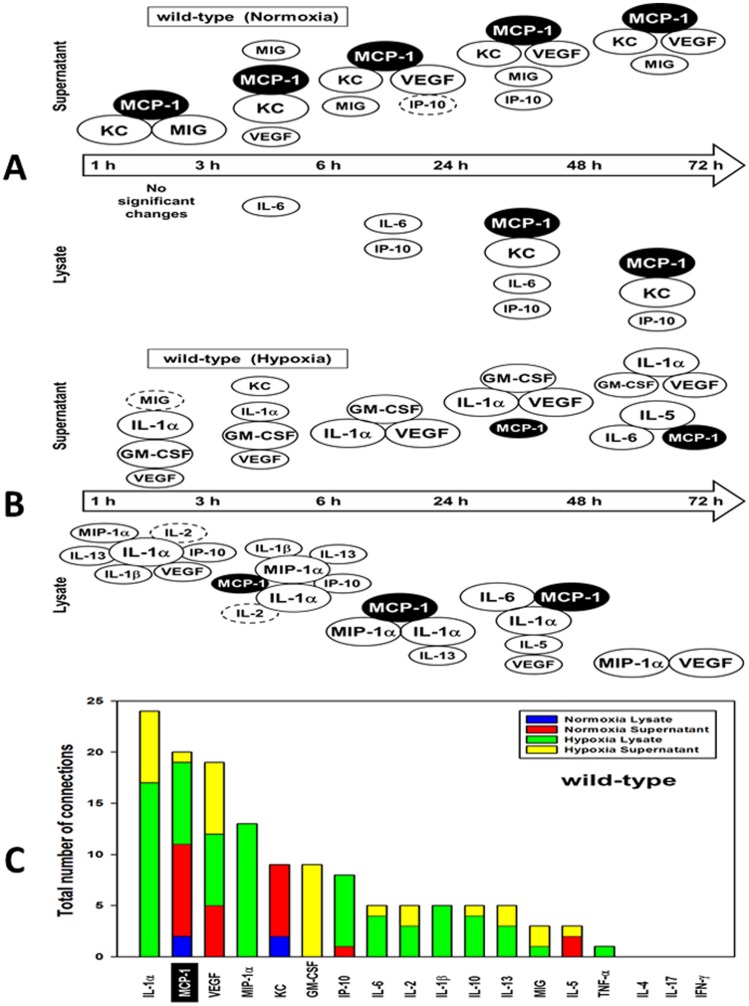
Dynamic Network Analysis (DyNA) of inflammatory mediators produced by normoxic and hypoxic mouse hepatocytes.Primary hepatocytes from wild-type mice were cultured under normoxic or hypoxic conditions (1–72 h) followed by measurement of inflammatory mediators in both lysates and supernatants and lysates as described in the
Materials and Methods
. After data normalization, DyNA during each of the following five time frames: 1–3 h, 3–6 h, 6–24 h, 24–48 h, and 48–72 h was performed for both lysates and supernatants as indicated. Panels show a summary of the DyNAs representing the most connected inflammatory mediator “nodes” for both normoxia (A) and hypoxia (B) lysates and supernatants. Each mediator's node size is proportional to the number of connections it has in a given time interval. (C) Stacked bars representing the total number of connections for each inflammatory mediator over all time intervals.